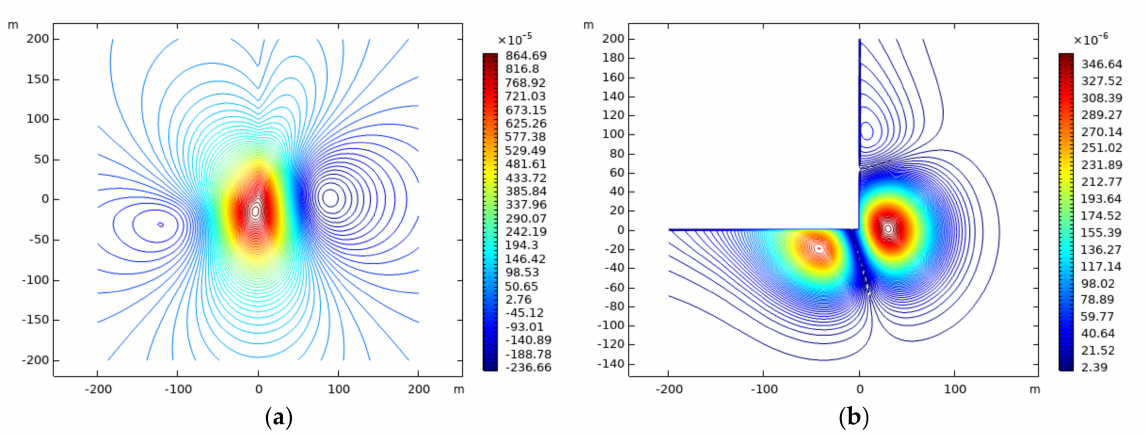
Figure 3. Schematic diagram of transient electromagnetic response in the full space state under the three-dimensional uniform medium. ( a ) Magnetic field distribution (A/m); ( b ) Current induction density (A/m 2 ).